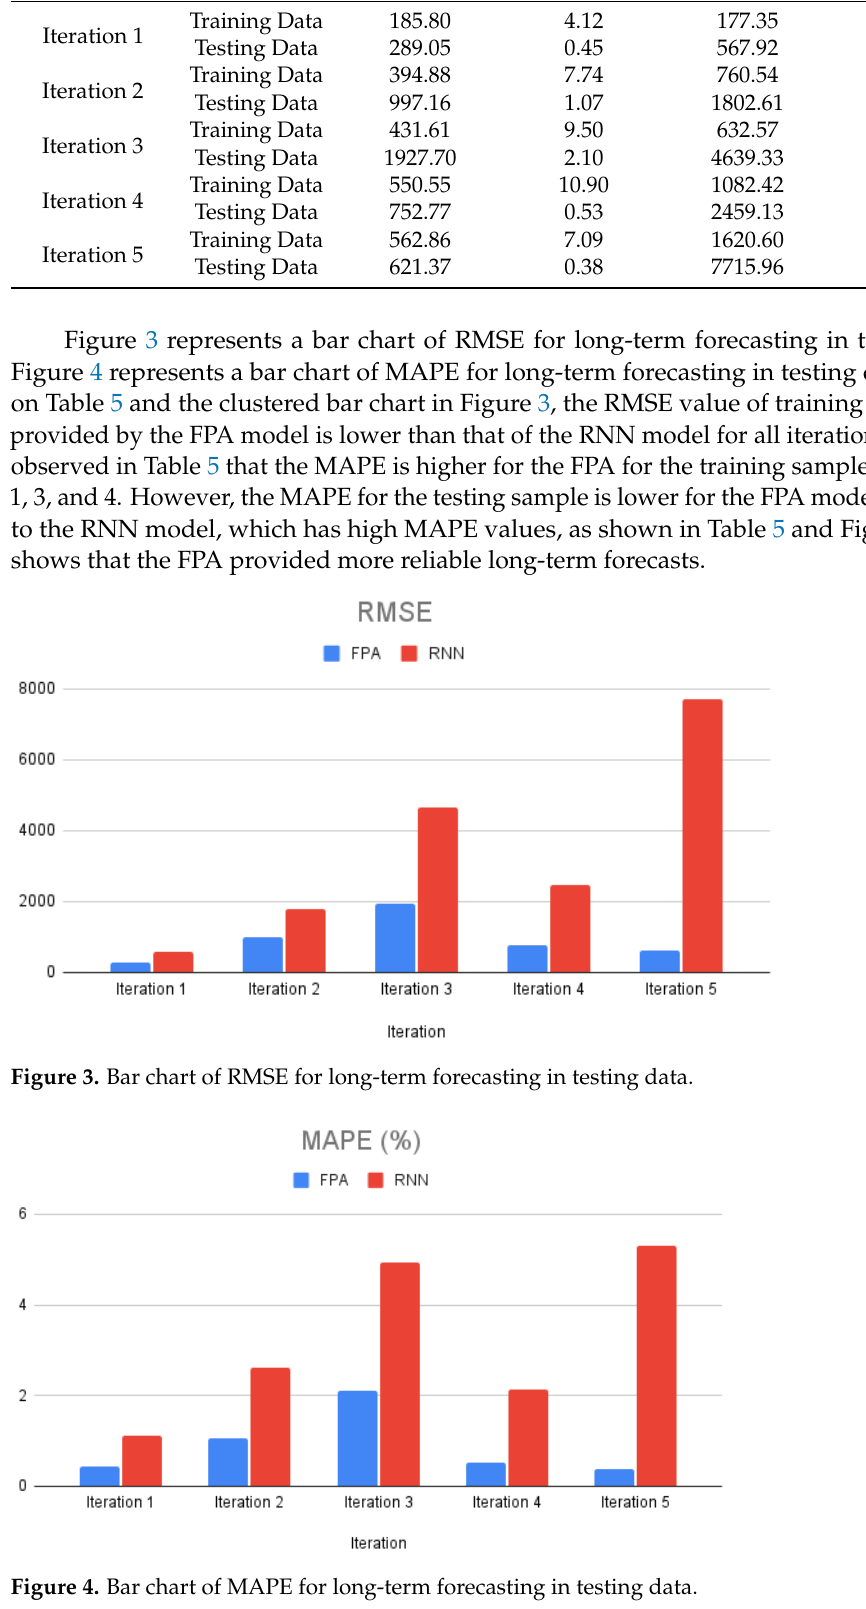
Table 5. Long-term forecasting results.